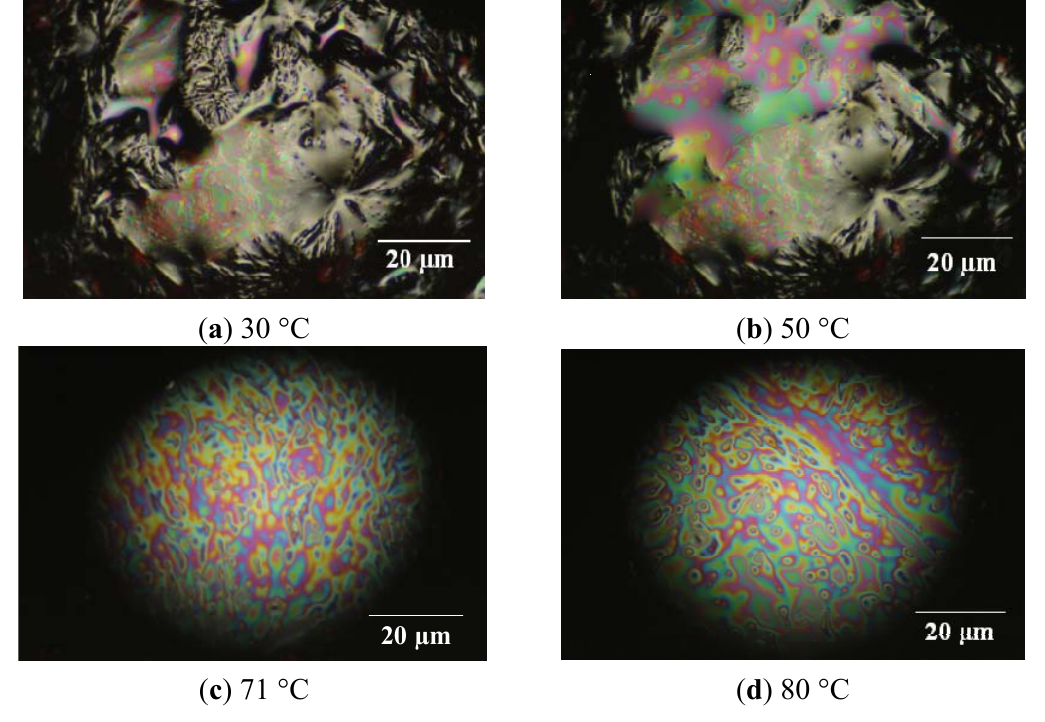
Figure 4. Liquid crystalline behaviour monitored by Light Polarized Microscopy Images OH for dendron 4G 1